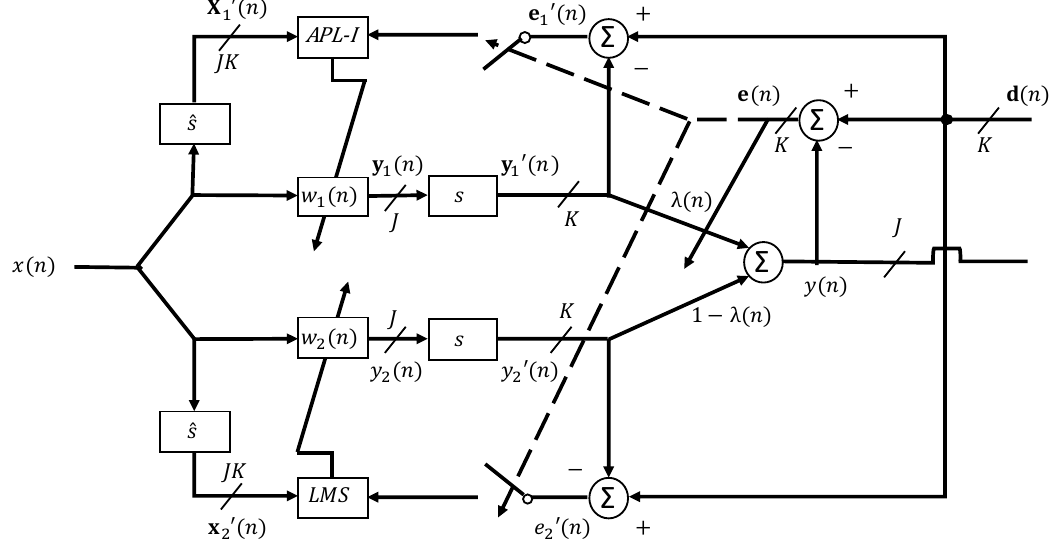
Figure 2. Block diagram of the proposed scheme with switching filter